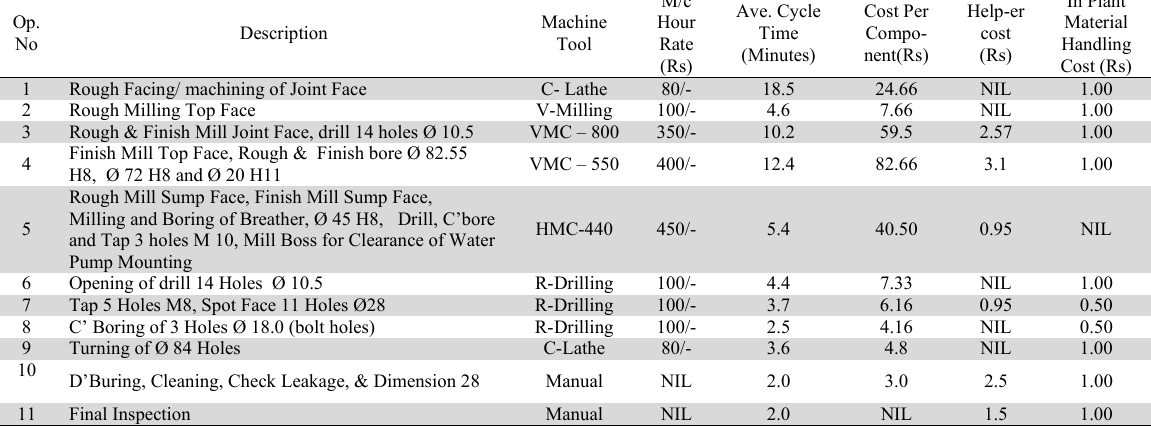
Operation time chart for improved process Op. No